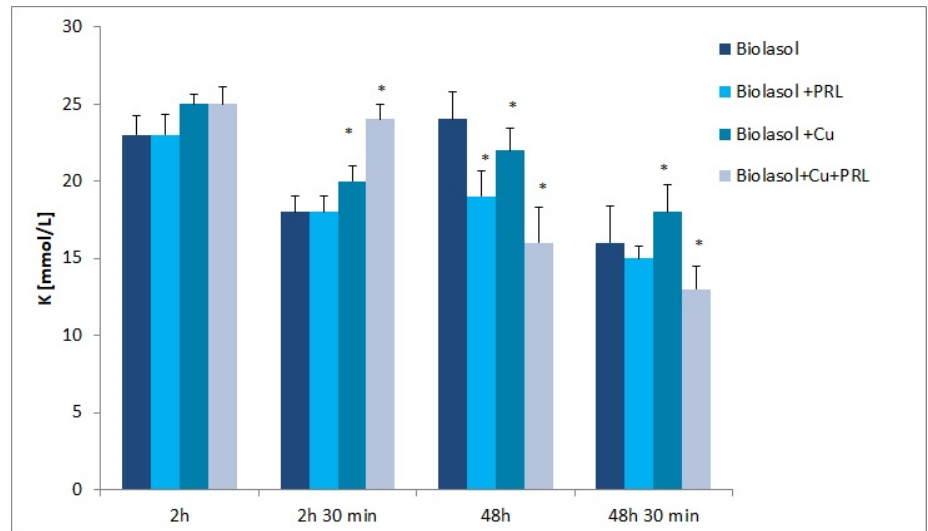
Figure 5. Sodium concentration in perfusate samples taken. The values are expressed as mean ± SEM. Data were analysed by one-way ANOVA and Bonferroni post hoc tests; n = 10; * p < 0.05; ** p < 0.01 compared to the control group (Biolasol).